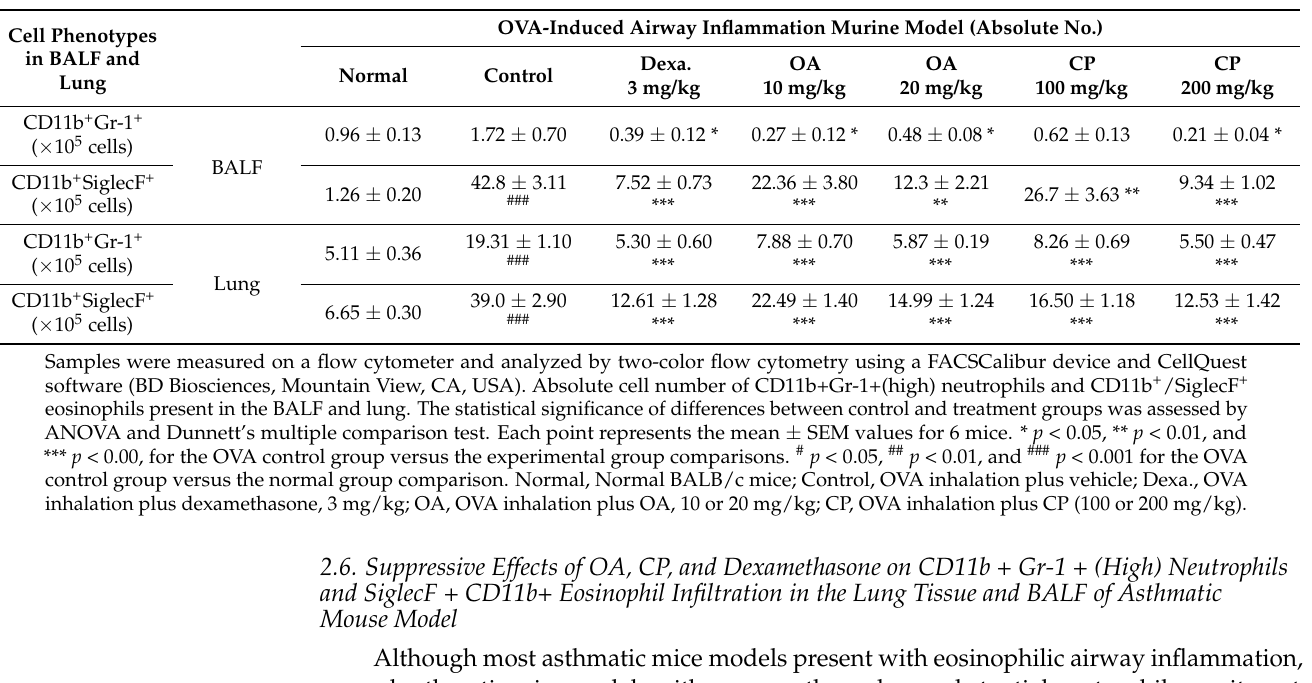
Table 2. Suppressive effect of OA, CP, and Dexa on CD11b + Gr-1 + (high) neutrophils and CD11b + SiglecF + eosinophils in the BALF and lung of OVA-induced asthmatic model